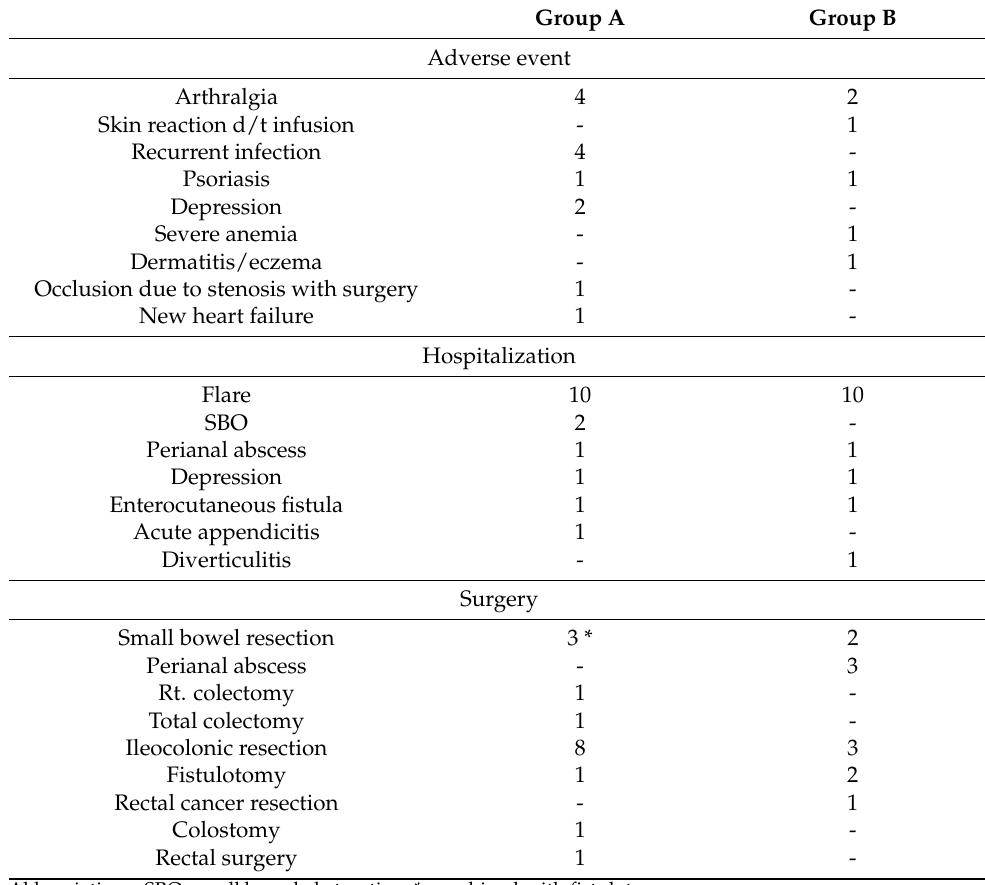
Table 3. Adverse events, hospitalization, and surgeries during the follow-up period in each